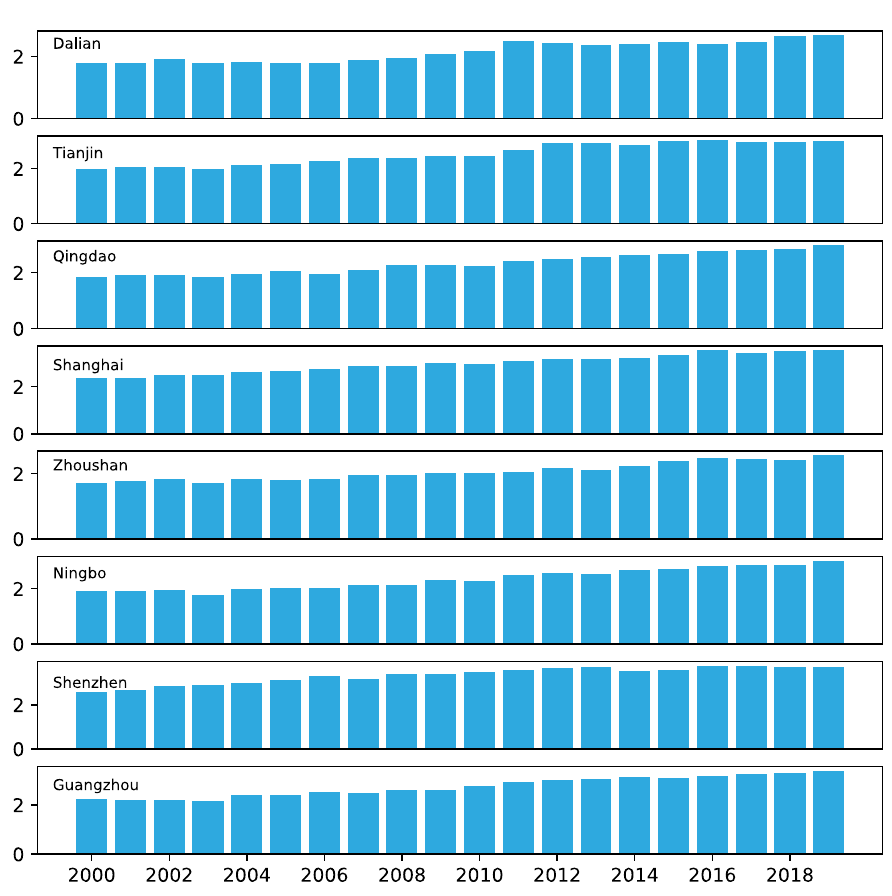
Figure 3. Time variability evaluation results of CMDRI.